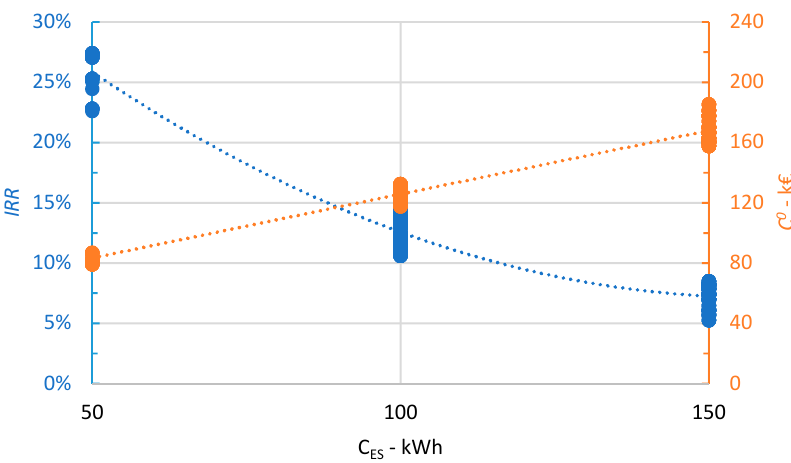
Figure 9. IRR and initial cost as a function of the nominal ES capacity.